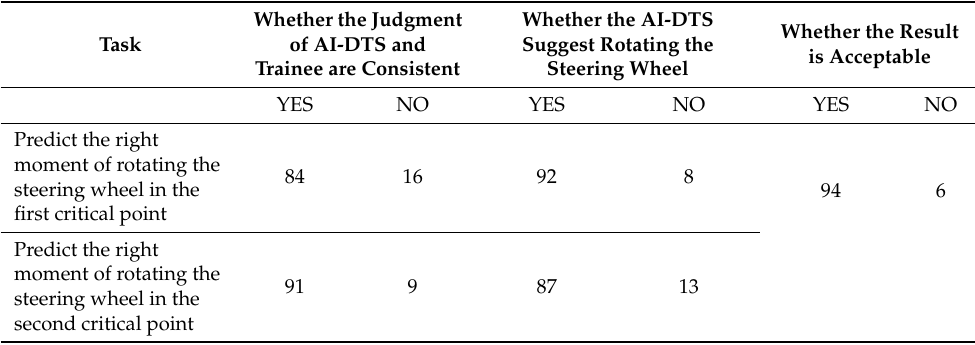
Table 2. Feedback of the experimenter.